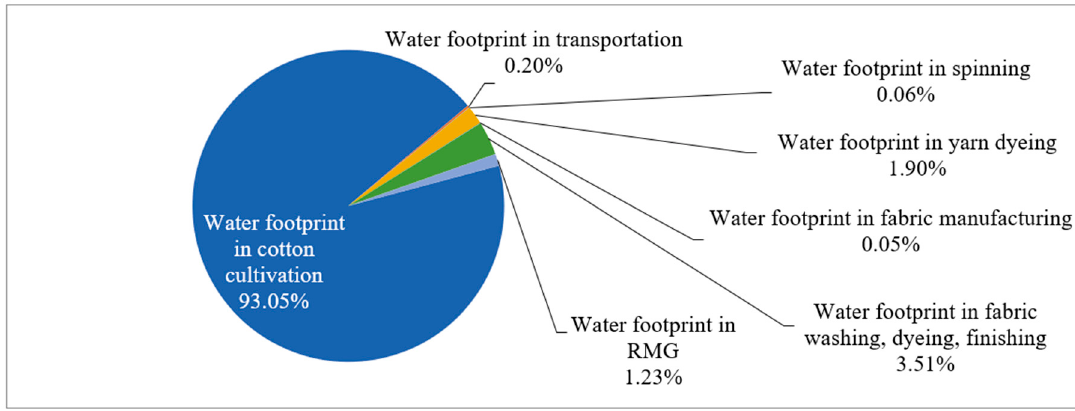
Figure 10. Percentage of water footprint in different stages of RMG production.